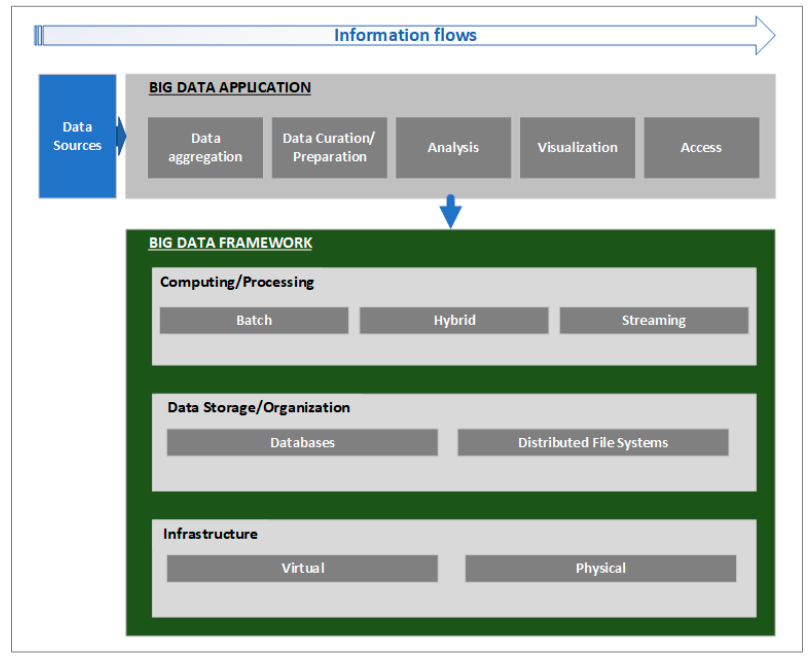
Figure 1. Big data systems overview.